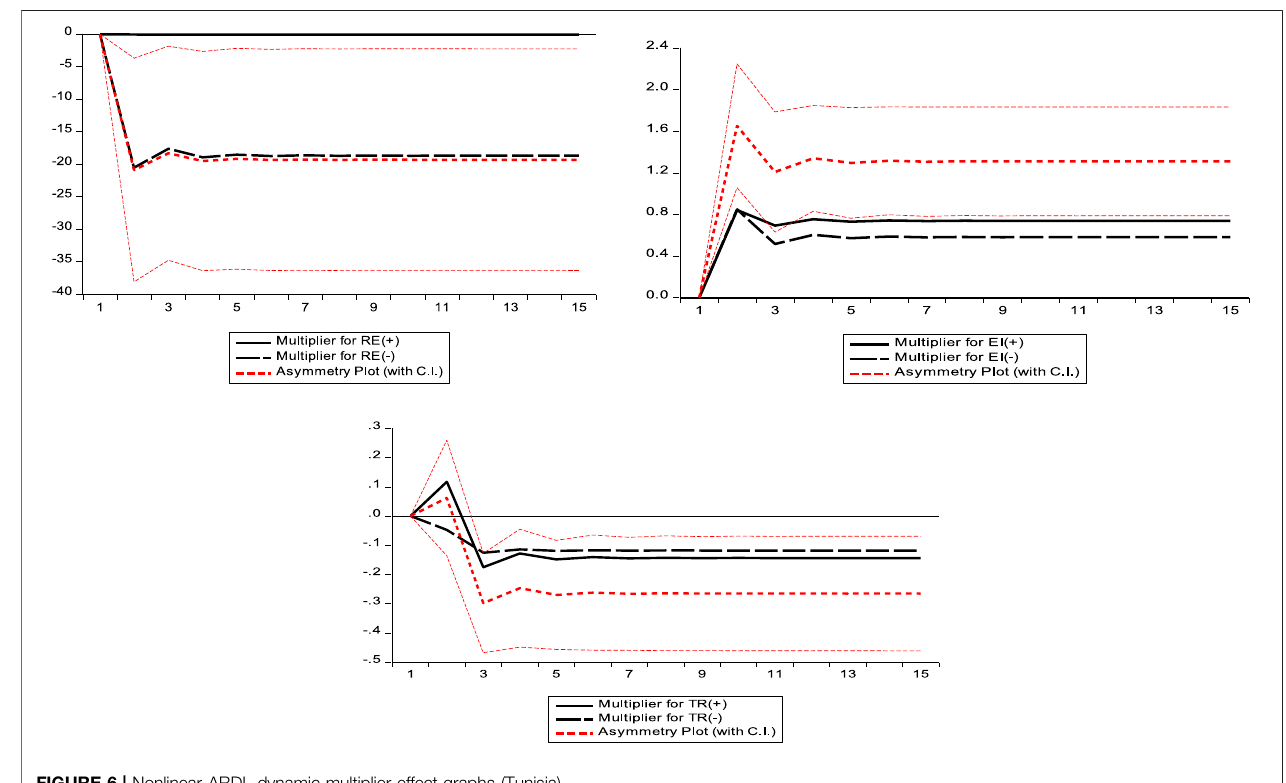
FIGURE 6 | Nonlinear ARDL dynamic multiplier effect graphs (Tunisia).